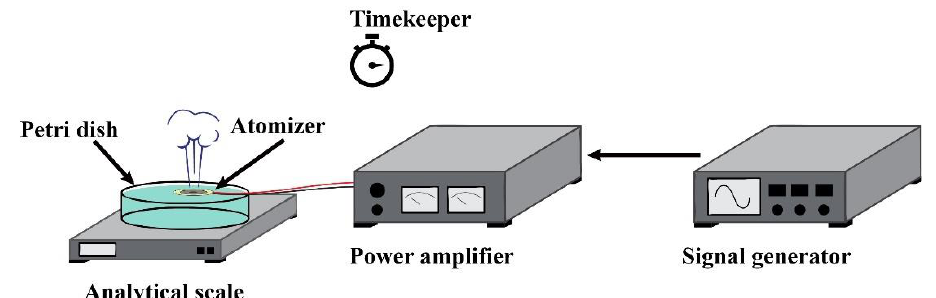
Figure 11. Scheme of the atomization rate measurements.